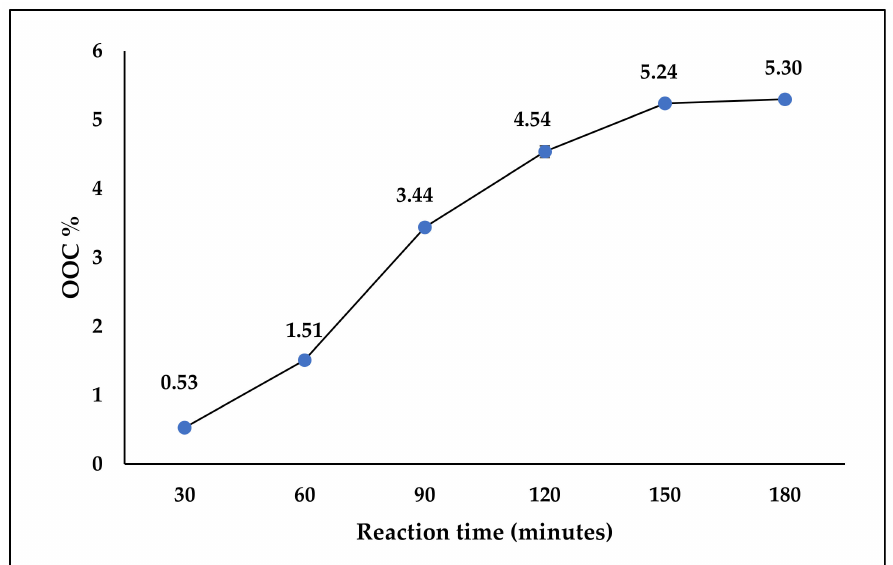
Figure 1. Oxirane oxygen profile for epoxidation reaction of methyl oleate.